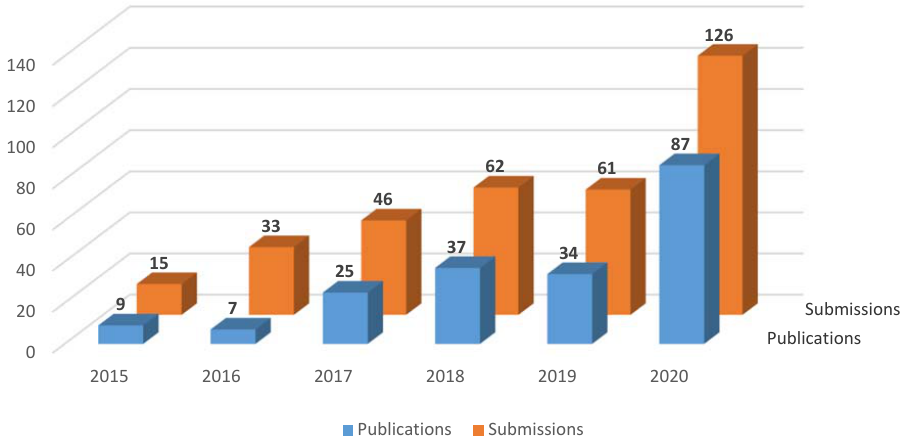
Figure 1. Number of submissions and publications (non-peer review article types such as editorials, corrections, obituaries, comments, replies, and meeting reports are excluded from the published papers) in 2015–2020.